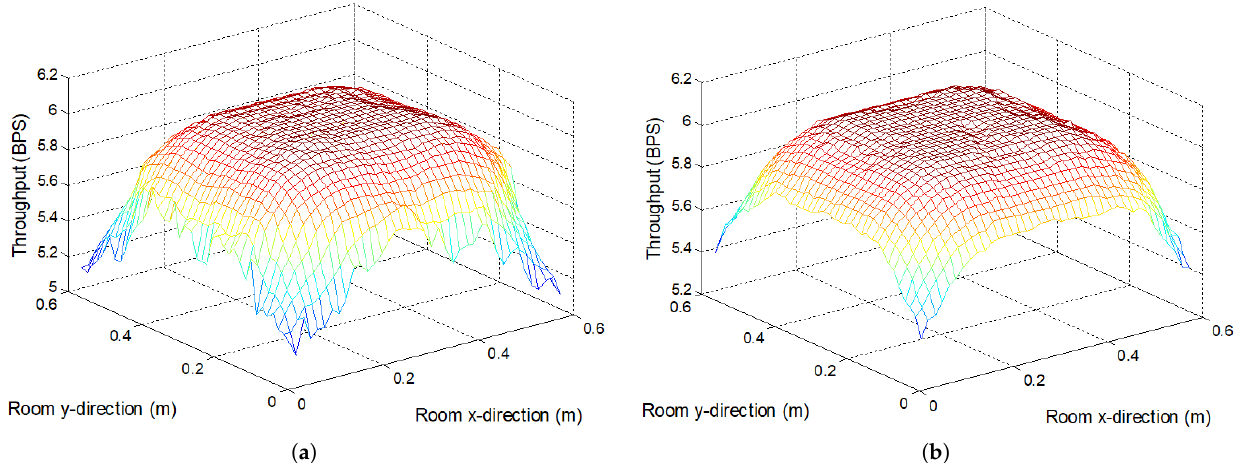
Figure 11. Simulated throughput in bits per symbol (BPS) at the receiver plane of the mockup by using the adaptive OFDM algorithm described in Section 3.2 (with P e = 3.8 × 10 − 3 ) for two situations: ( a ) Receiver pointing upward (th max = 6.1 BPS, th mean = 5.8 BPS, th min = 5.1 BPS). ( b ) Receiver oriented as defined by Equation (14) (th max = 6.1 BPS, th mean = 5.9 BPS, th min = 5.3